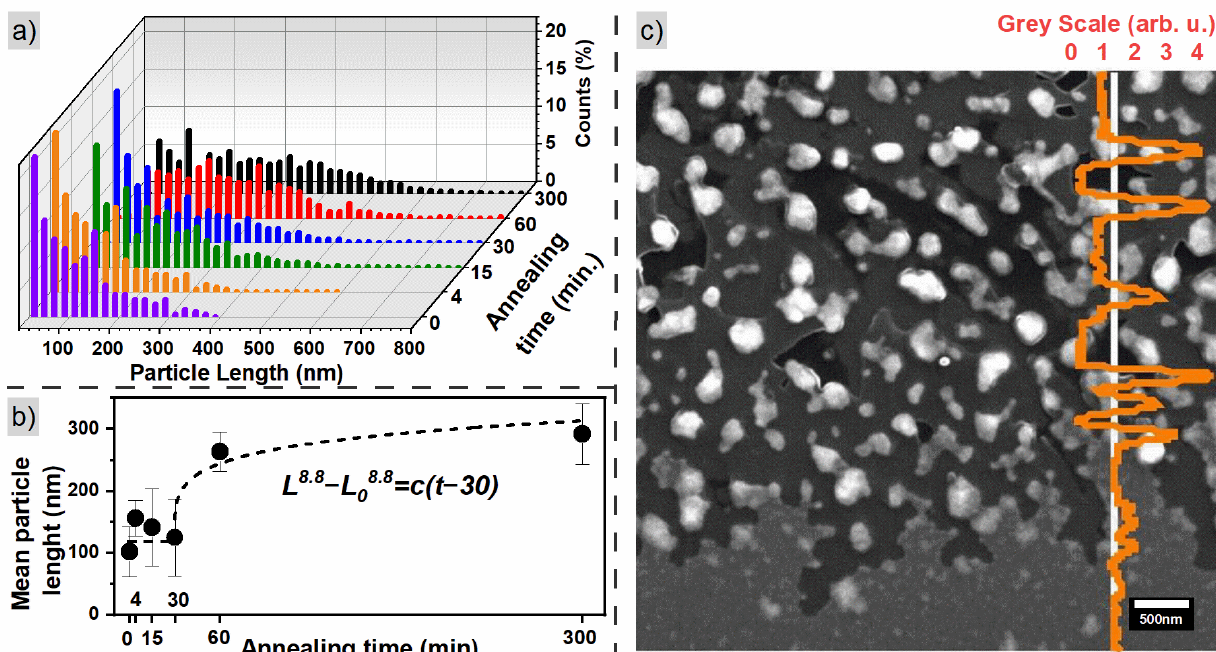
Figure 3. ( a ) Histogram of particle sizes from SEM microscopy fitted with gamma distribution, different colors correspond to different times of annealing; ( b ) particle size mean values; ( c ) SEM image at the void edge of the sample annealed for 4 min showing successive changes in film morphology. The orange line on the right side of the image shows the variation in the grayscale of the SEM signal, where 0 corresponds to the darkest regions, i.e., uncovered silica substrate, and 1 corresponds to the regions of unchanged FePd thin film.